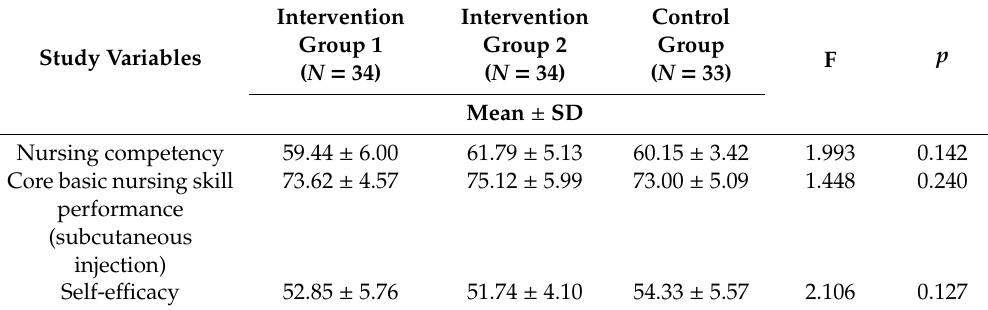
Table 2. Homogeneity of study variables at the pre-intervention among three